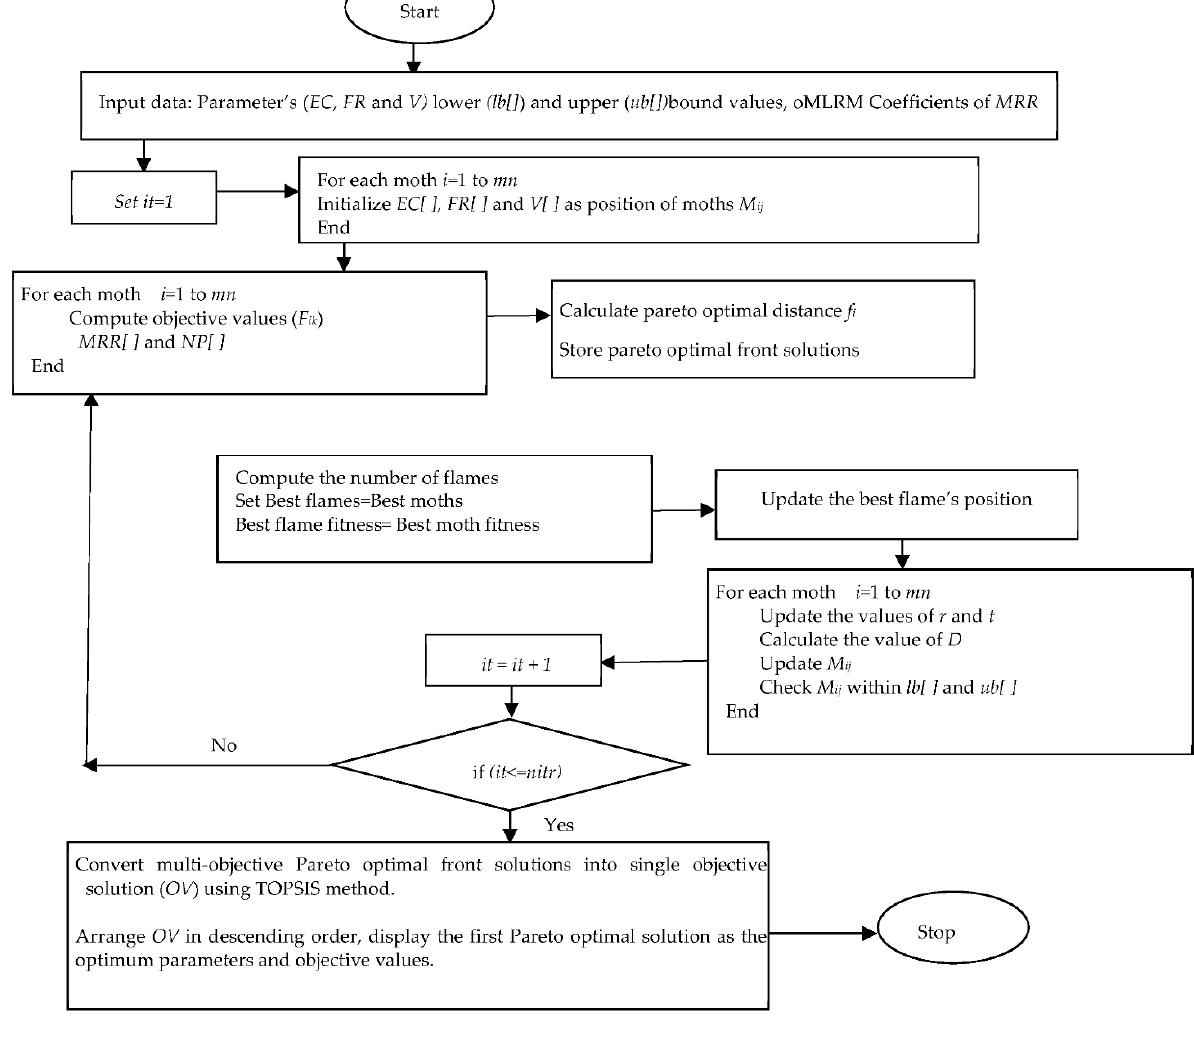
Figure 13. Implementation of MFO algorithm.